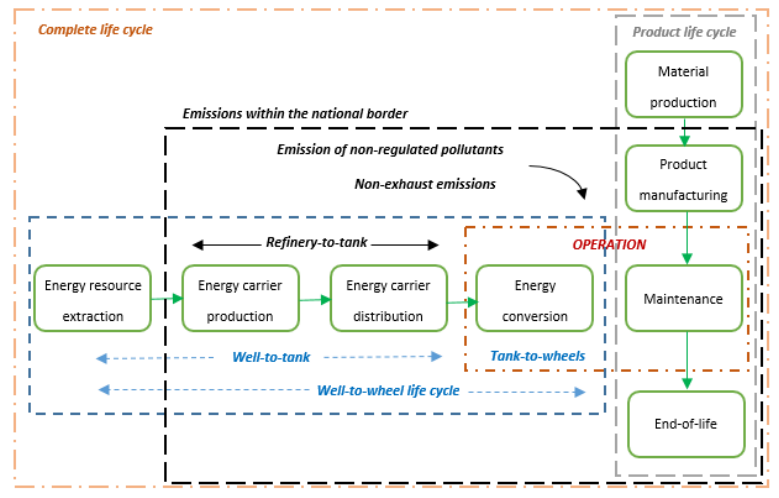
Figure 3. Flowchart of the LCA approach (based on [36,41]).